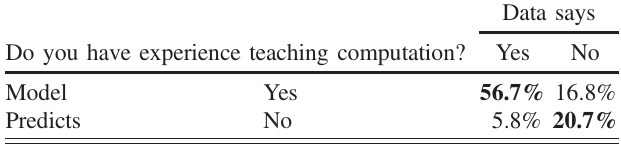
TABLE I. Confusion matrix for a representative trial of the 30 trials. Numbers in bold are correct predictions and add to the